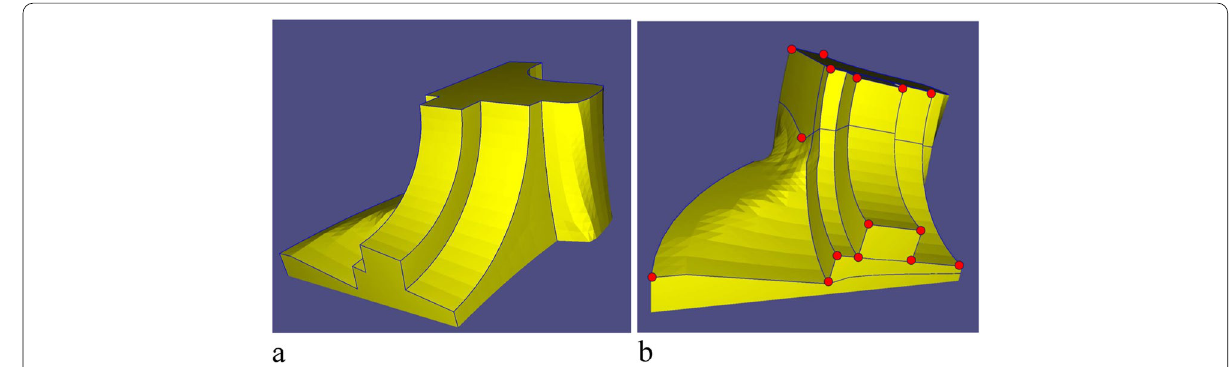
Fig. 7 Information on Fandisk model. a Sharp features; b Edges between EPs (red dots)